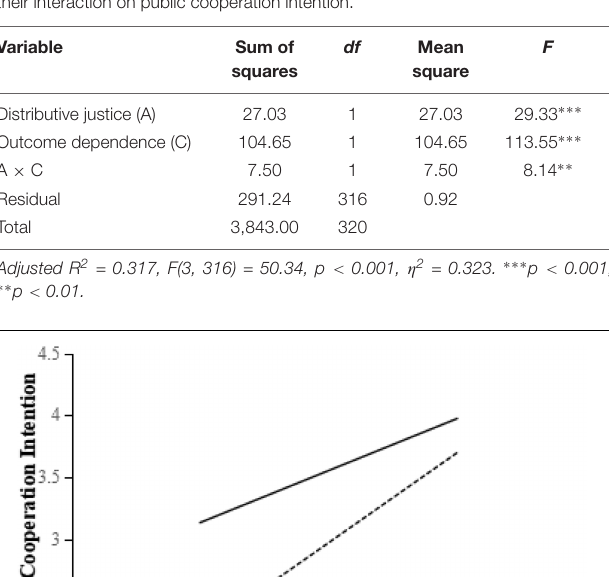
was significantly stronger in the low outcome